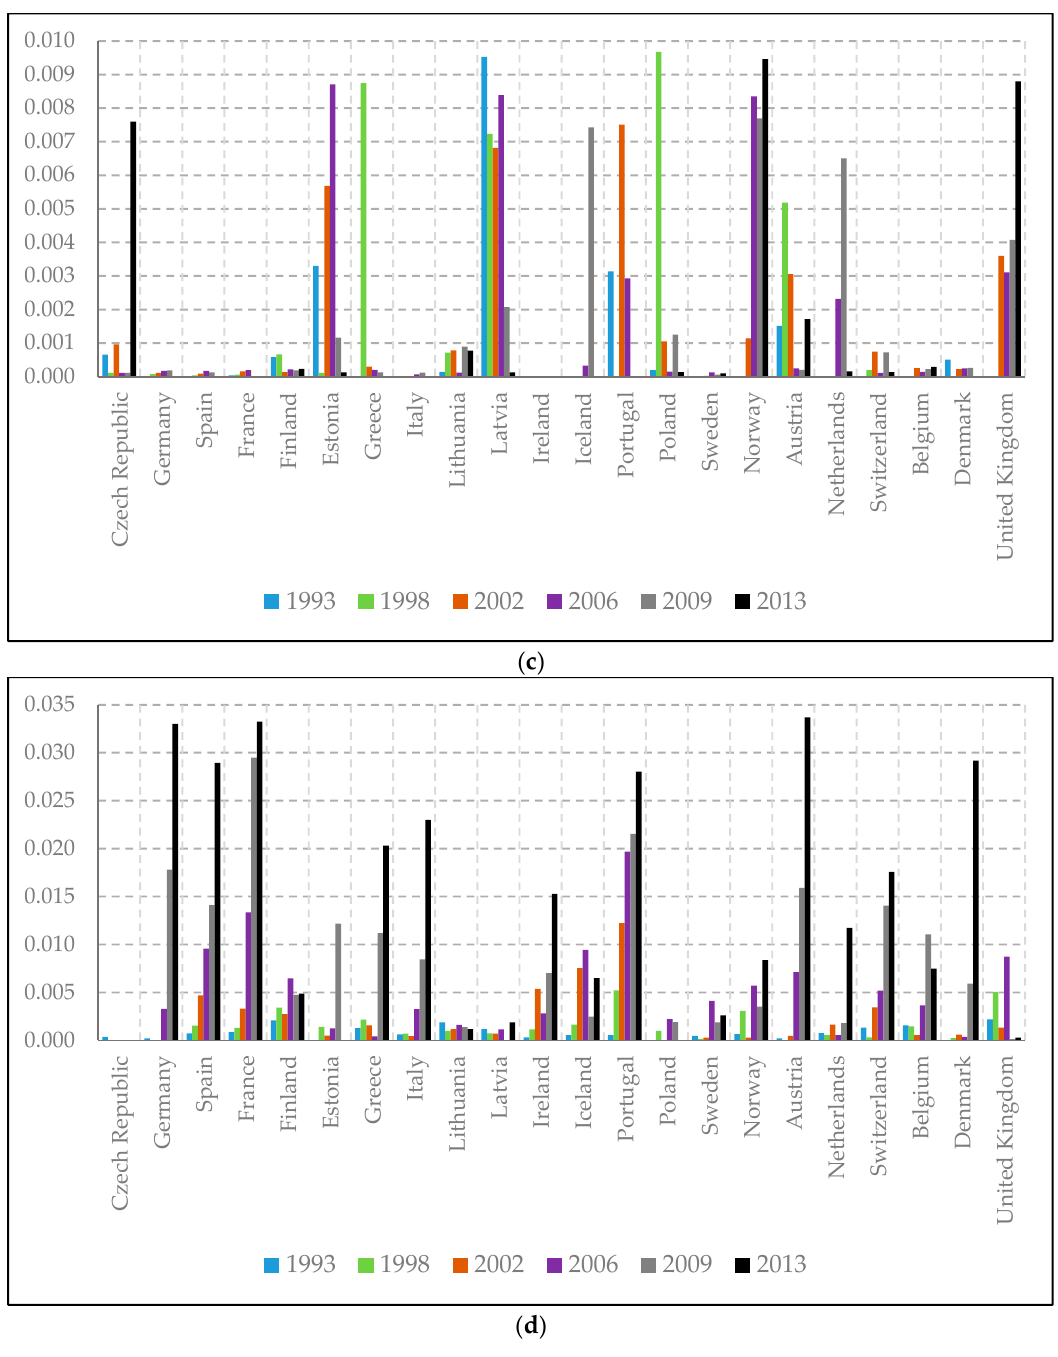
Figure 2. Parameter values estimated for male gender in selected years of the period 1993–2013: ( a ) Infant mortality (parameter θ ); ( b ) Population aging (parameter ξ ); ( c ) Individual unexpected mortality (parameter κ ); ( d ) Population mortality due to hazardous events (parameter λ ).